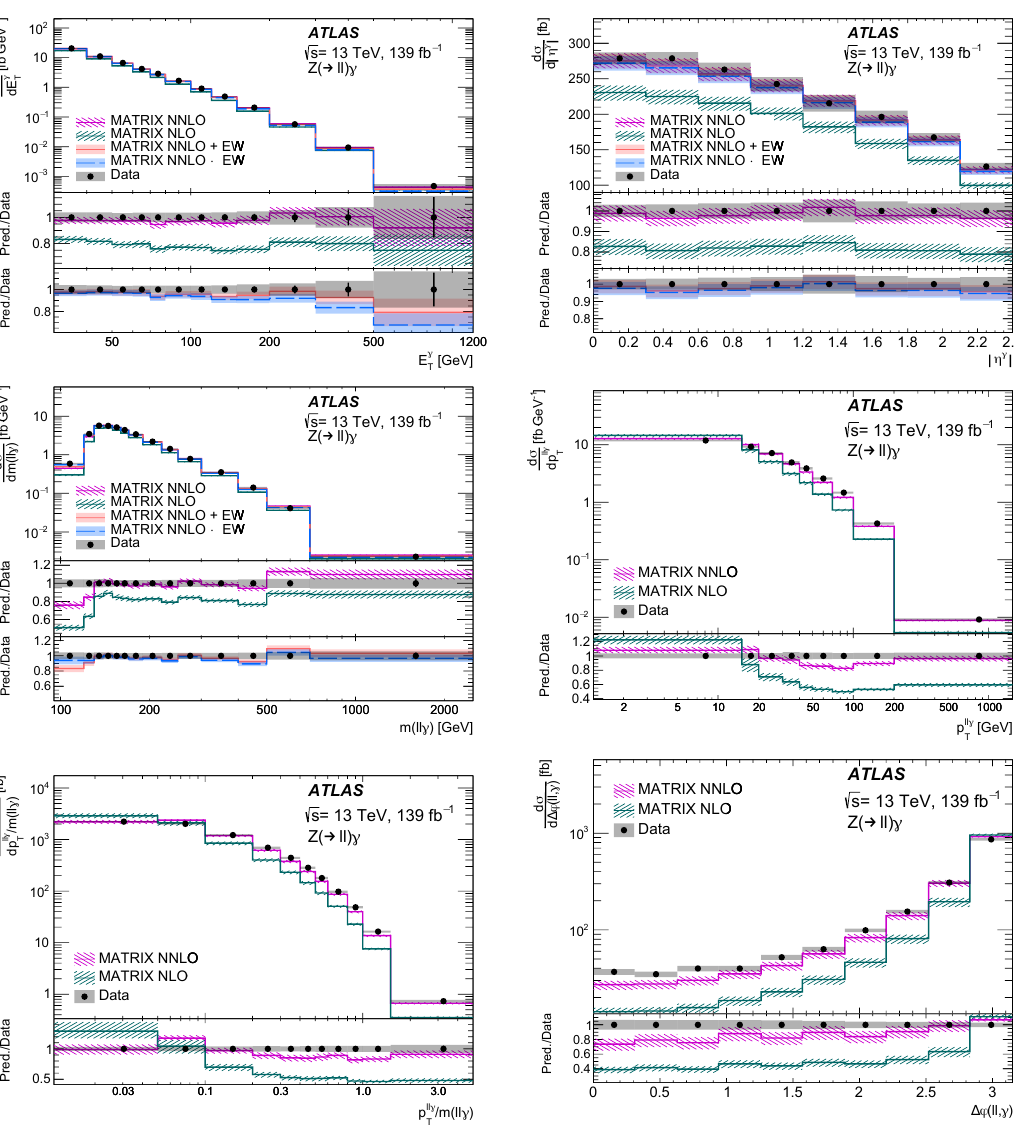
Figure 7 . Measured (cid:12)ducial cross-sections (black data points) for the observables (from left to right and top to bottom) E (cid:13) , j (cid:17) (cid:13) j , m ( ‘‘(cid:13) ), p ‘‘(cid:13) , p ‘‘(cid:13) =m ( ‘‘(cid:13) ) and (cid:1) (cid:30) ( ‘‘; (cid:13) ) for the pp ! Z ( ‘ + ‘ (cid:0) ) (cid:13) T T T process. The measured cross-sections are compared with SM expectations obtained from the Ma- trix parton-level generator, corrected to particle level. The error bars on the data points show the statistical uncertainty in the measured values. The grey shaded regions show the total uncertainty in the unfolded data, excluding the uncertainty in the integrated luminosity. The purple and green hatched regions show the total uncertainty in the Matrix predictions. For the quantities E (cid:13) , T j (cid:17) (cid:13) j and m ( ‘‘(cid:13) ), the blue (orange) histograms show the Matrix NNLO cross-sections with EW NLO corrections applied multiplicatively (additively), while the blue (orange) shaded regions show the corresponding total uncertainties. The lower panel(s) in each plot show the ratio of the SM expectation to the measured